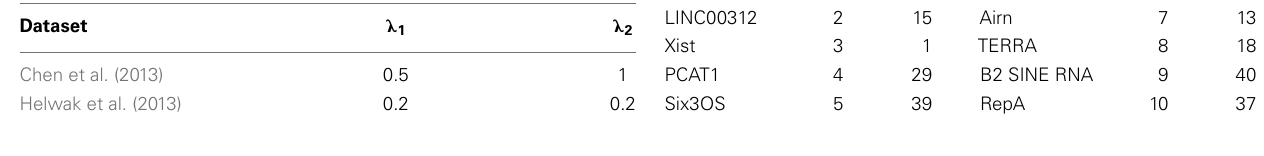
Table 4 | Optimal values of λ 1 and λ 2 parameters for the datasets used in our experiments .